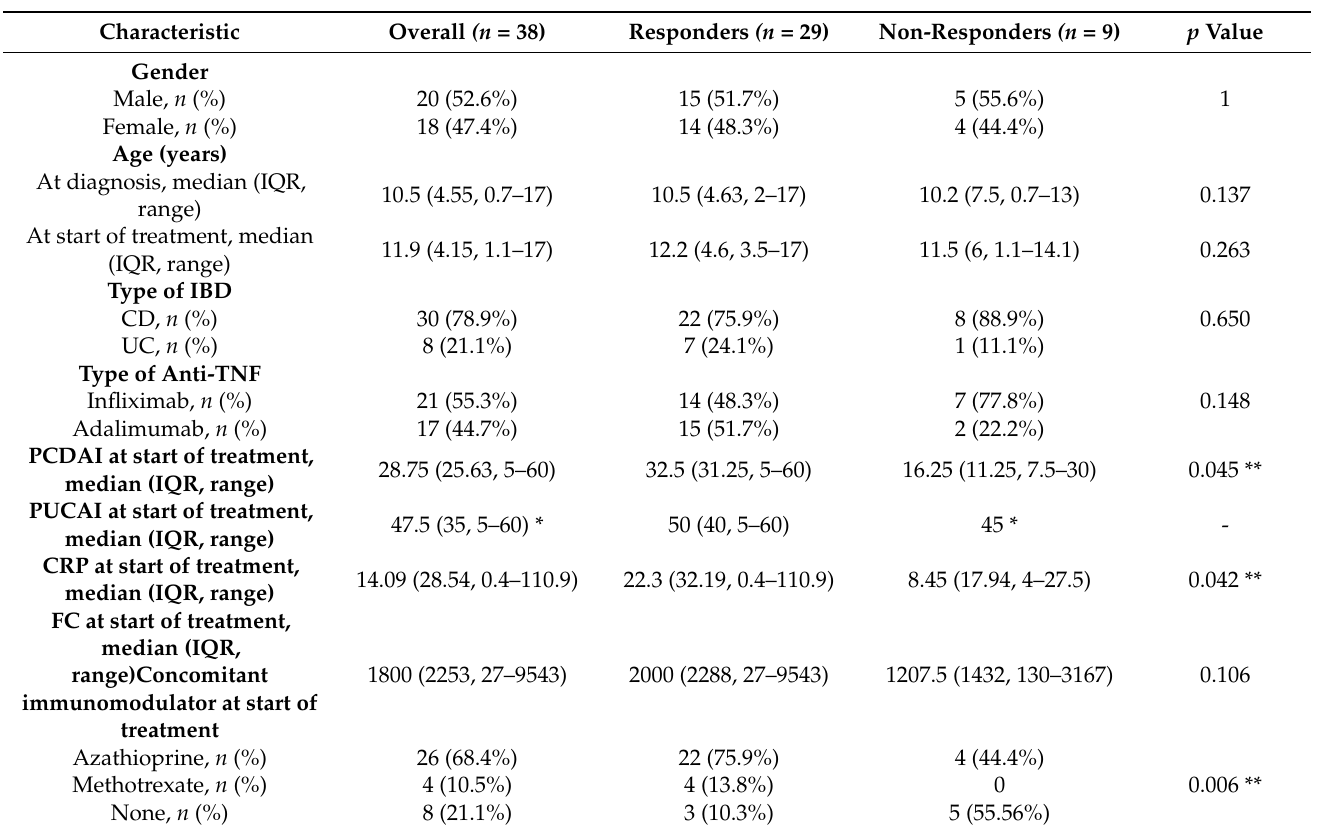
Table 2. Characteristics of